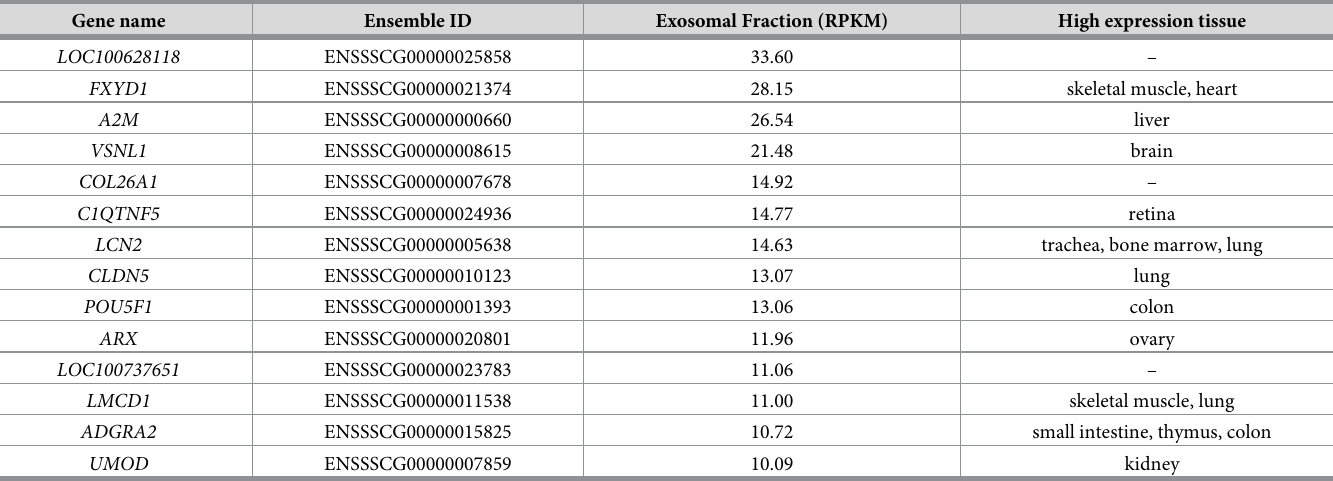
Table 3. Unique mRNAs in exosome-like vesicles undetected in